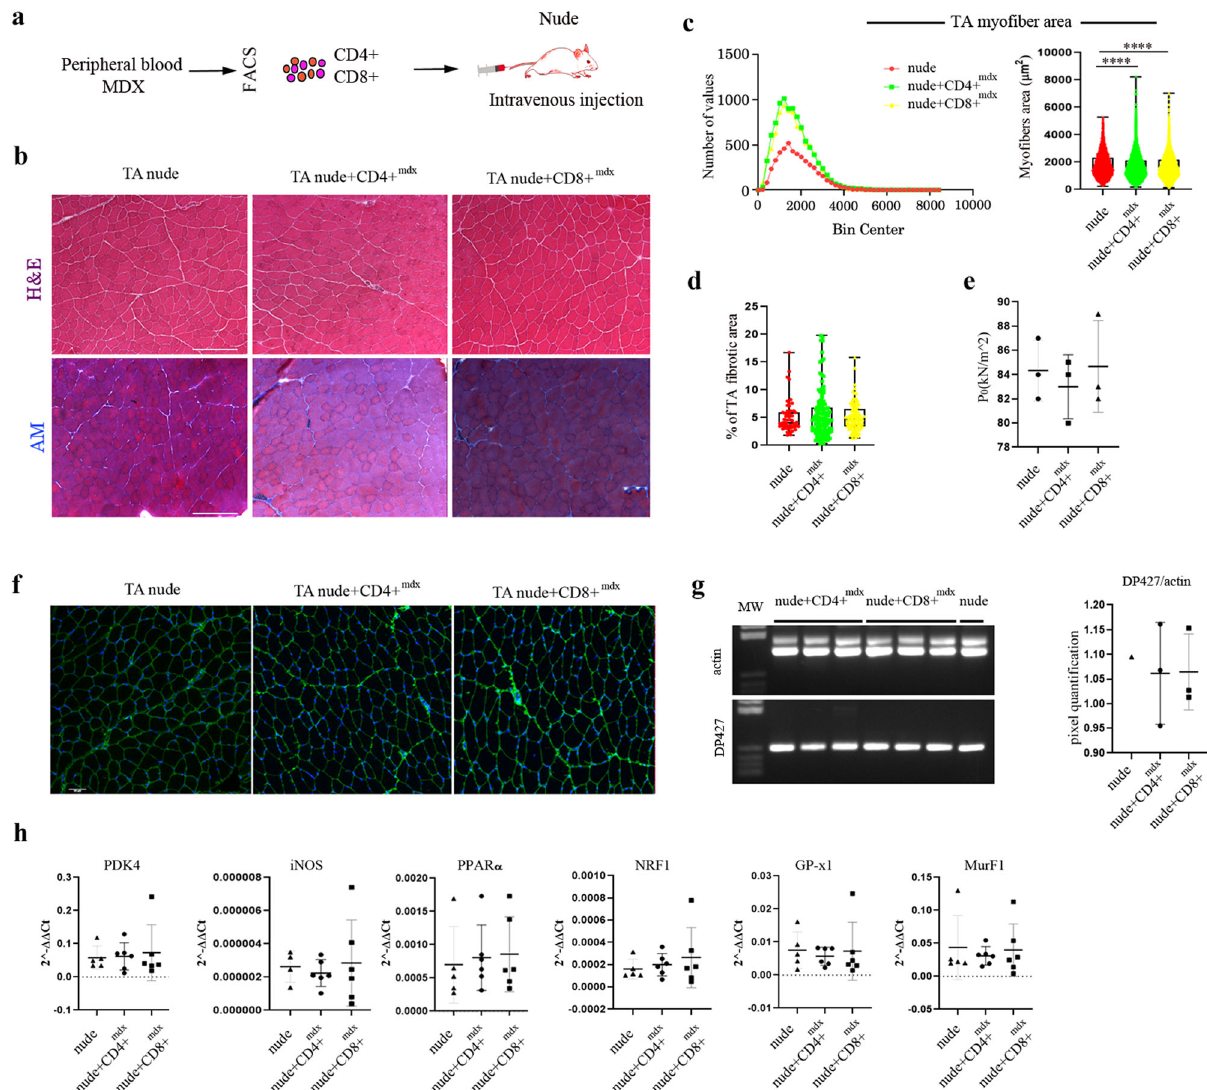
Fig. 8 Morphometric and functional analysis of skeletal muscles of nude mice following CD4 + and CD8 + lymphocytes transplantation. Schematic overview of the experimental procedure ( a ). Representative H&E and AM staining of TAs from nude, nude + CD4 + mdx and nude + CD8 + mdx mice ( b ). Quanti fi cation of the relative frequency of the myo fi ber cross-sectional area (CSA) expressed as the frequency distribution of TA muscles of nude, nude + CD4 + mdx and nude + CD8 + mdx mice (nude: minimum, median, maximum and range: 247.5, 1666, 5265, 5017, respectively; 25% percentile, 75% percentile, coef fi cient of variation: 1158, 2320, 46.51%, respectively. nude + CD4 + mdx : minimum, median, maximum and range: 183.7, 1531, 8239, 8055, respectively; 25% percentile, 75% percentile, coef fi cient of variation: 1042, 2132, 50.31%, respectively. nude + CD8 + mdx : minimum, median, maximum and range: 120.9, 1548, 7033, 6912, respectively; 25% percentile, 75% percentile, coef fi cient of variation: 1065, 2176, 49.21%, respectively) ( c ). Quanti fi cation of fi brotic areas of TA muscles of nude, nude + CD4 + mdx and nude + CD8 + mdx mice (mean area: nude: 5.044; nude + CD4 + mdx : 5.532; nude + CD8 + mdx : 5.182) ( d ). For morphometric analysis, images were quanti fi ed with ImageJ software for each mouse. Tetanic force of TA of nude, nude + CD4 + mdx and nude + CD8 + mdx mice is shown in e . Representative immunostaining with dys-2 (C-terminal-domain) antibody showed comparable dystrophin intensity around the myo fi bers in TA of nude, nude + CD4 + mdx and nude + CD8 + mdx mice ( f ). Representative image of RT-PCR analysis of TA of nude, nude + CD4 + mdx and nude + CD8 + mdx mice determined similar expression of Dp427 dystrophin isoform ( g ). RT-qPCR experiments on TA muscles of treated and untreated mice demonstrated no differences of expression of genes speci fi cally involved in autophagy, skeletal muscle metabolism, mitochondrial biogenesis and muscle atrophy ( h ). Scale bar: 200 μ m ( a ), 50 μ m ( f ). The comparisons among the averages of the groups were evaluated using one-way ANOVA ( c ). c **** p < 0.0001. Data are presented as mean ± SD of three independent experiments with n = 3 mice/group. Source data are provided as a Source Data fi